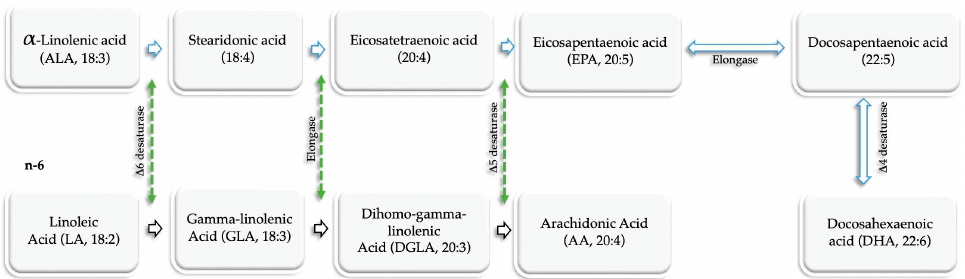
Figure 2. De novo synthesis of n-3 and n-6 PUFAs. n-3 PUFAs are derived from ALA. ALA in the liver is desaturated to stearidonic acid and then elongated to eicosatetraenoic acid, which is then desaturated to EPA. DHA is synthesized from EPA in a two-step reaction sequentially catalyzed by elongase and desaturase. The biosynthesis of n-6 PUFAs starts with the conversion of linoleic acid to DGLA via desaturation and elongation reactions. DGLA is then further desaturated